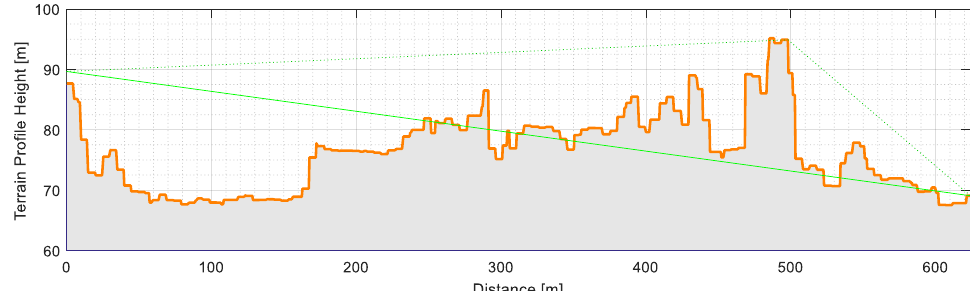
Figure 12. Distance profile between the waste container at Spacio Shopping and the LoRa gateway at ISEL.